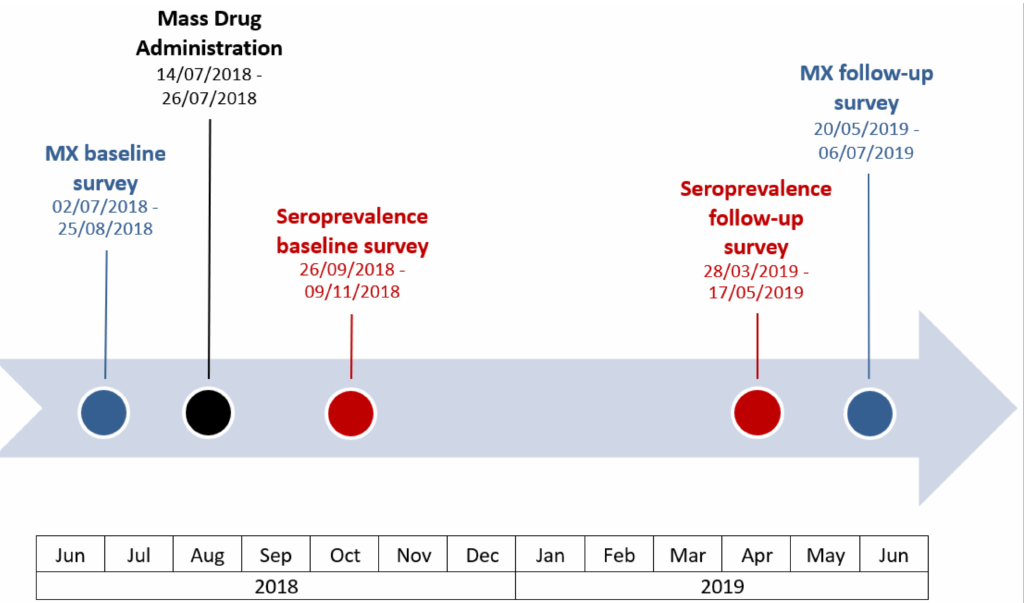
Figure 2. Timeline of 2018 and 2019 surveys (human and mosquitoes) relative to the rollout of the triple-drug mass drug administration [18] in